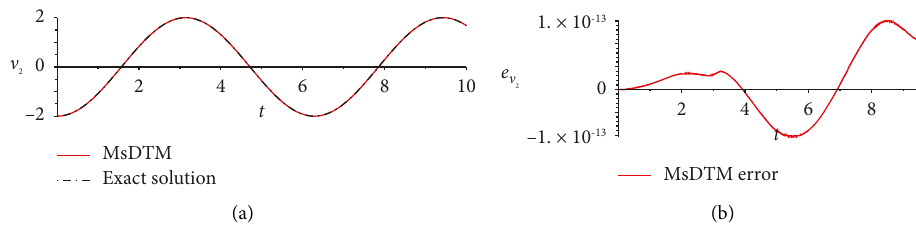
Figure 4: The approximate solution component v